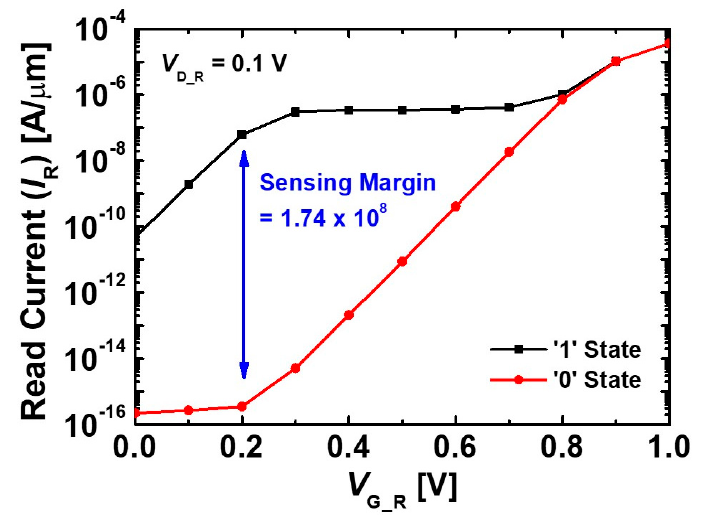
Figure 7. Read currents I R1 and I R0 as functions of V G_R at the temperature of 300 K.